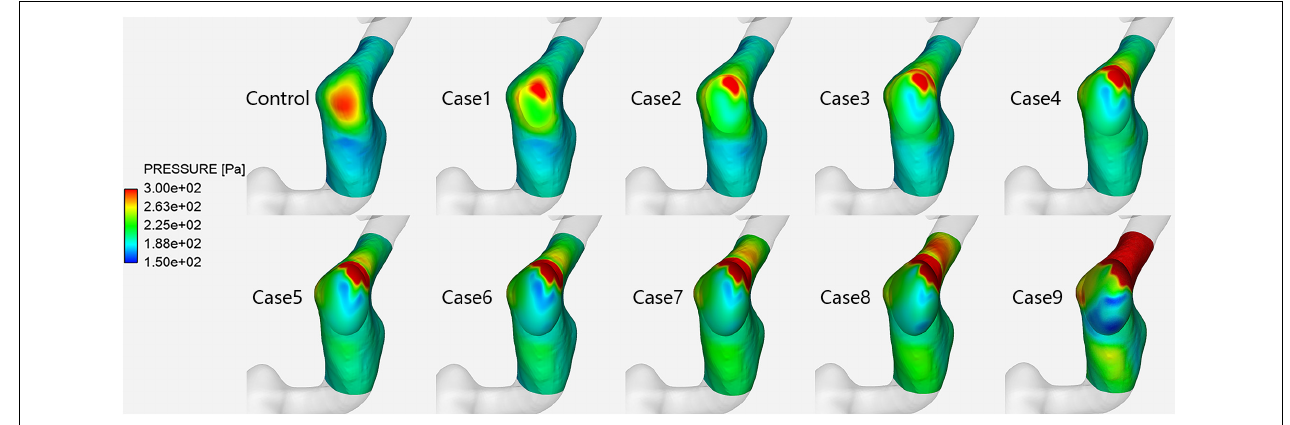
FIGURE 2 | Vessel wall pressure distribution in each case at the prominent transverse-sigmoid sinus junction (PTSJ).